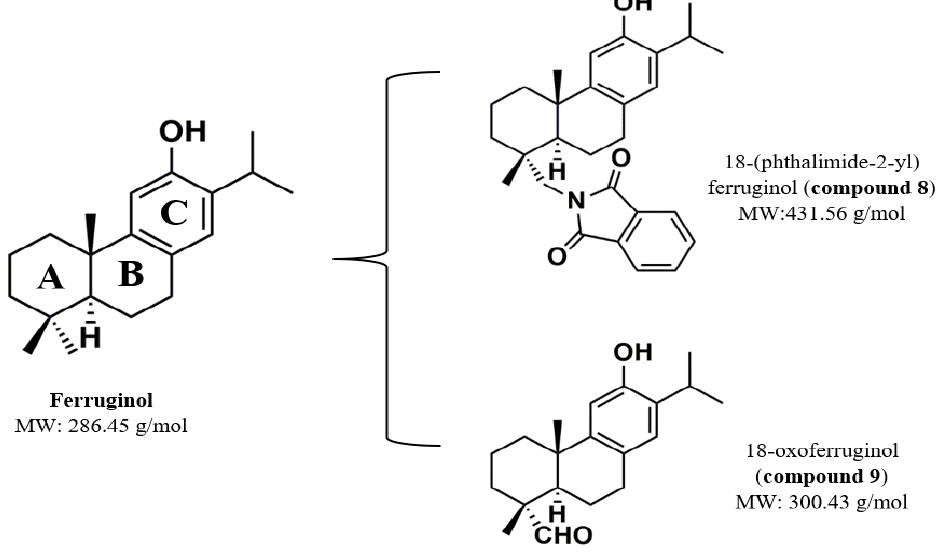
Figure 4. Chemical structure of ferruginol and two of its analogs, 18-(phthalimide-2-yl) ferruginol (compound 8) and 18-oxoferruginol (compound 9). MW: molecular weight. 18-(phthalimide-2-yl) ferruginol displays a phthalimide group in ring A of the ferrugi- nol backbone, specifically in carbon 18, as indicated in Figure 4. Phthalimide is an